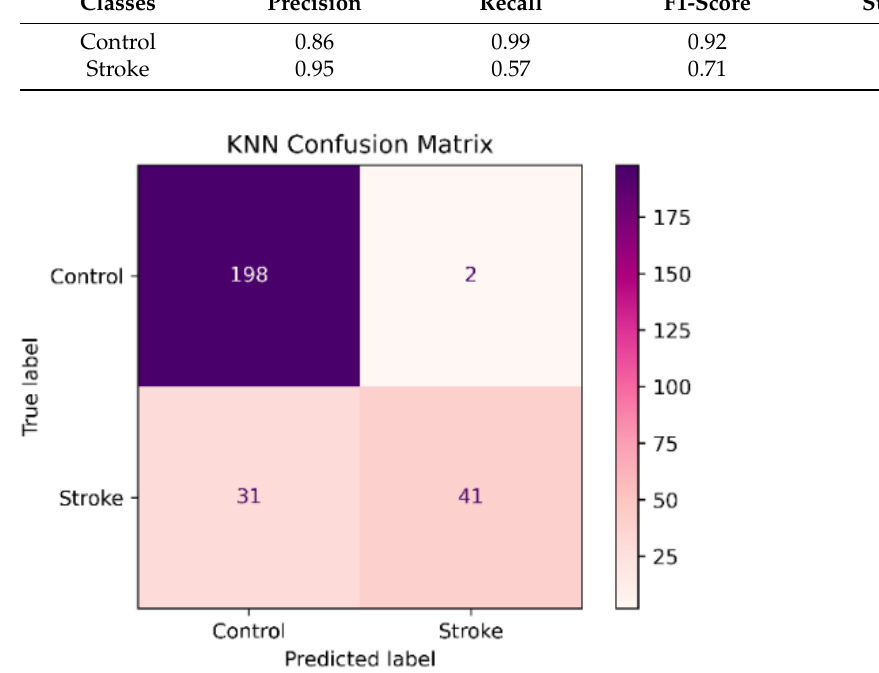
Figure 2. Random Forest Confusion Matrix. Table 4. K-nearest neighbor model classification report.